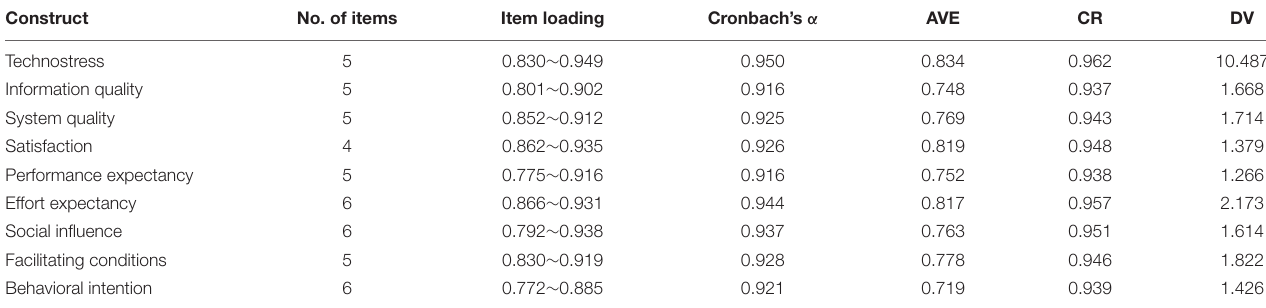
TABLE 2 | Construct reliability